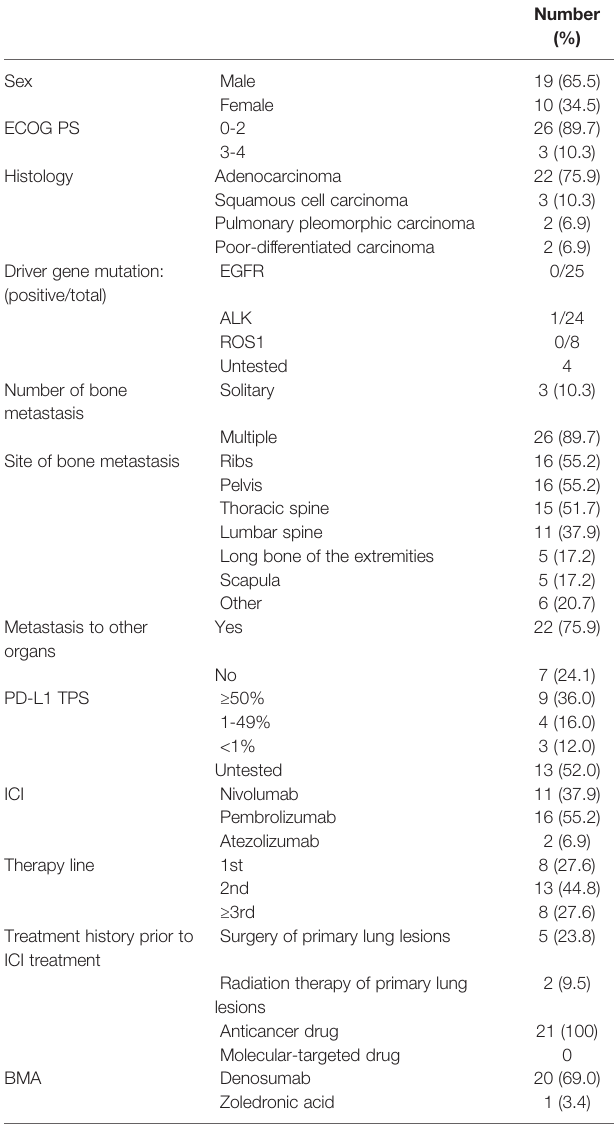
TABLE 1 | Characteristics of patients with advanced NSCLC treated with